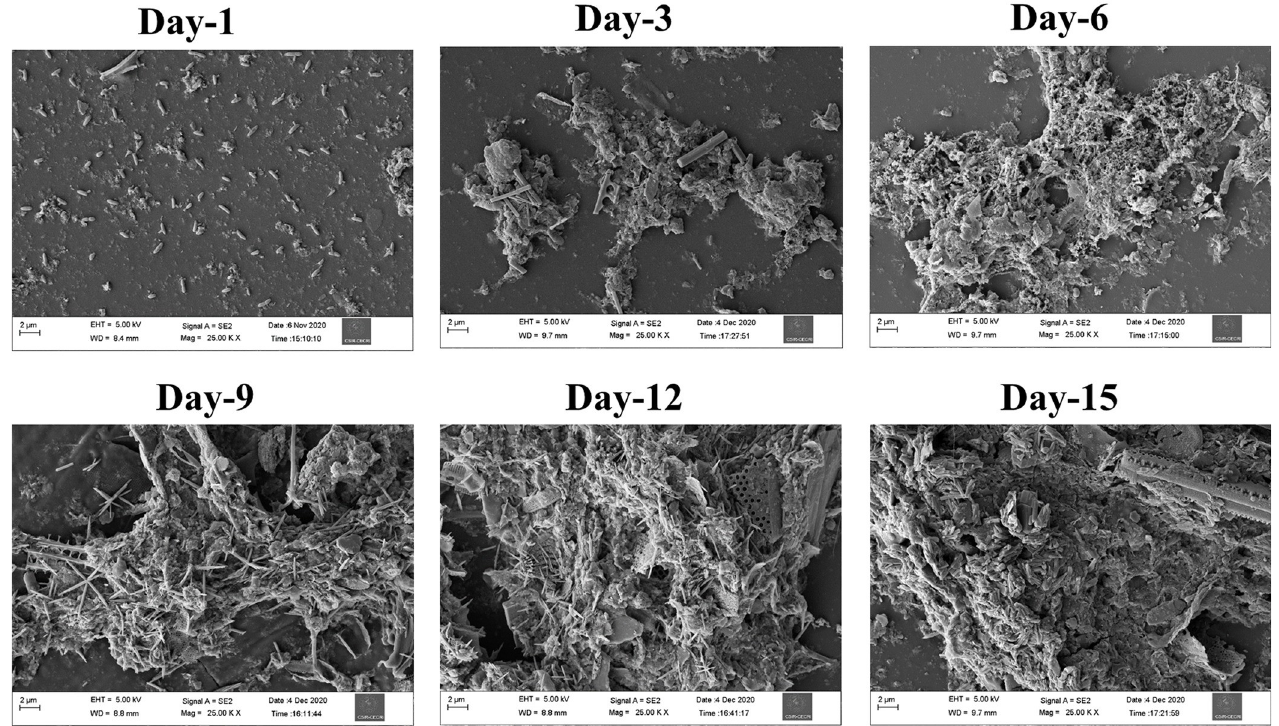
Fig 1. Representative field-emission scanning electron microscope (FESEM) images of acrylic coupons deployed in the intake area of a power plant located in the Laccadive Sea for different durations (1, 3, 6, 9, 12 and 15 days). Images display an increase in biofilm biomass and exopolymeric substance (EPS) with increasing